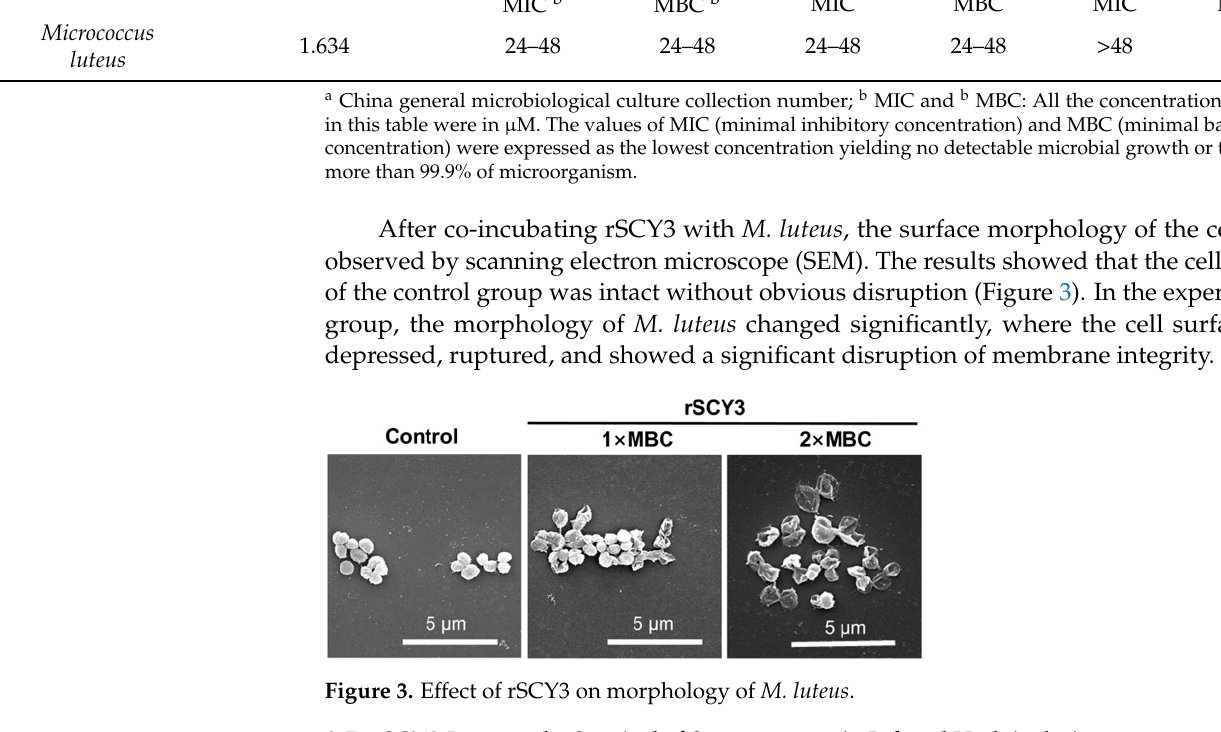
Figure 4. Evaluation of in vitro cytotoxicity and in vivo protective effect of rSCY3 on S. paramamosain infected by V. alginolyticus . ( A ) Cytotoxicity effect of recombinant protein rSCY3 on hemocytes iso- lated from male crabs. ( B ) In vivo protective effect of rSCY3. Crabs were challenged with V. algino- lyticus at 5 × 10 7 CFU, and injected with 60 µg rSCY3 at 1 h after bacterial challenging (n = 20 for each group). The survival curve of each group was analyzed using the Kaplan–Meier log-rank test. The asterisk indicated a significant difference compared with the control group (* p < 0.05). To assess the effect of rSCY3 in vivo, S. paramamosain was challenged with V. algino- lyticus . One hour after bacterial injection, 20 µL of rSCY3 (60 µg) or crab saline was injected into the crabs. The survival rate of the control group decreased to 10 % at 36 h post-injec- tion, while the rSCY3 treatment group showed a 50 % survival rate (Figure 4B). In total, 110 h after challenge, 90 % of the crabs in the control group died, while the survival rate of the experimental group remained around 35 % (Figure 4B). In general, S. paramamosain treated with rSCY3 after bacterial challenge exhibited a significantly higher survival rate than that of crabs injected with crab saline until 110 h ( p = 0.0213). 2.6. The Interaction between SCY1-SCY5 Thus far, a total of five SCYs have been found in S. paramamosain [14,26,27], a conjec- ture that the complexes of scygonadin homologous protein formed play a similar role in sperm AR raised from the previous study of SCY2 and scyreprocin. Whether these pro- teins interact with each other to form complexes involved in the activities of mud crab deserves investigation. Recombinant His-tagged SCY1-SCY4 (rSCY1-rSCY4), Trx-tagged SCY5 (rSCY5), and Trx (rTrx) were expressed and purified (Figure S3). Surface plasmon resonance assay (SPR) indicated that the calculated equilibrium dissociation constant (K D ) of the rSCY1–rSCY2, rSCY1–rSCY3, rSCY1–rSCY4, rSCY1–rSCY5, rSCY2–rSCY3, rSCY2–